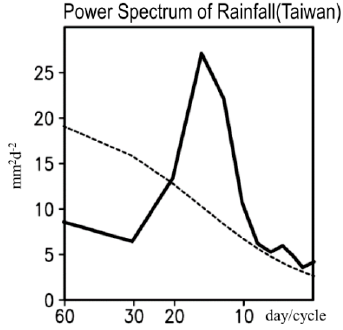
Figure 3. Power spectrum analysis of the time series of daily rainfall area averaged over Taiwan (120–122° E, 22–25.5° N) during May and June 2017, extracted from Figure 1b. The dashed line indicates the related 95% confidence interval.